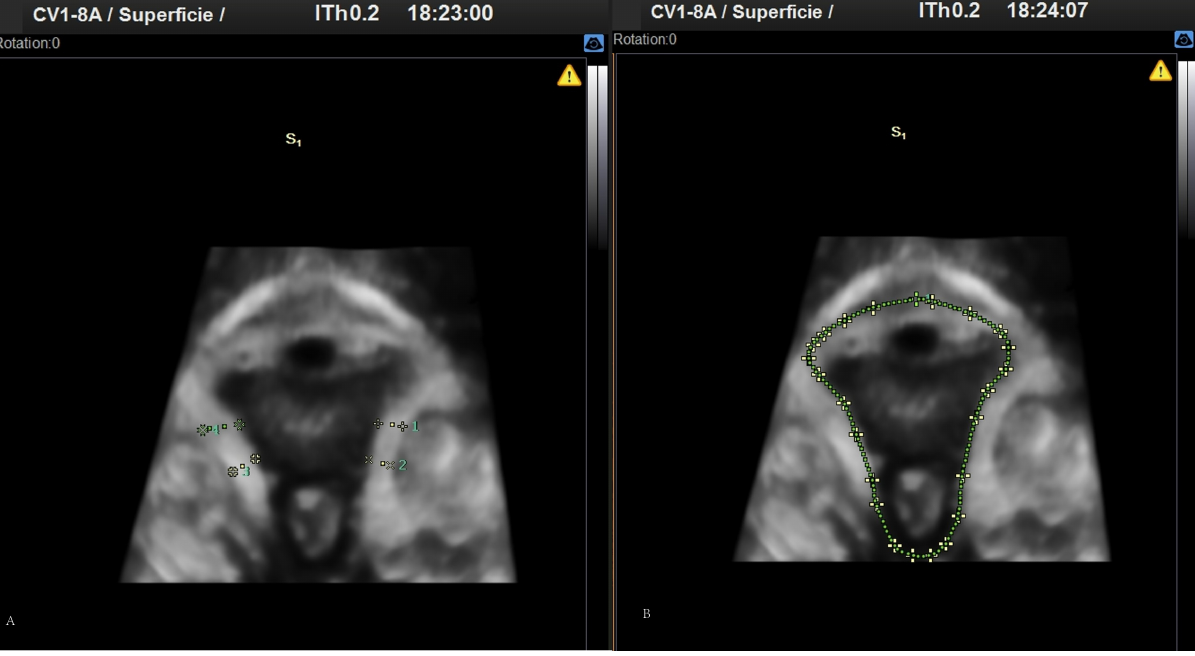
Figure 2. 3D images obtained by perineal ultrasound. ( A ) Pubovisceral muscle thickness. ( B ) Perineal hiatus area.